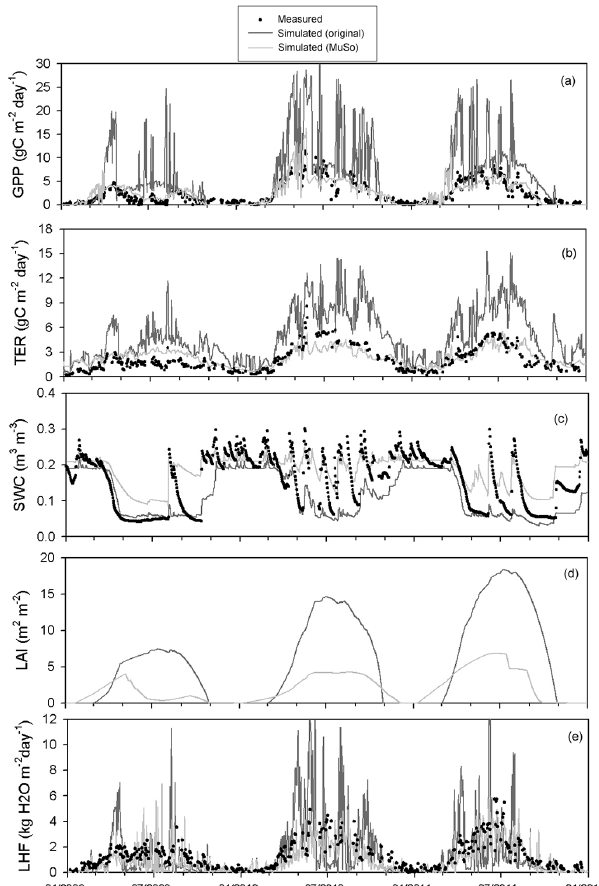
Figure 6. Measured (black dots) and simulated variables (a) GPP, (b) TER, (c) SWC, (d) LAI, (e) LHF using the original Biome- BGC (dark grey lines) and BBGCMuSo (light grey lines) models for grassland at the Bugac site between 2009 and 2011. Measured LAI was not available at